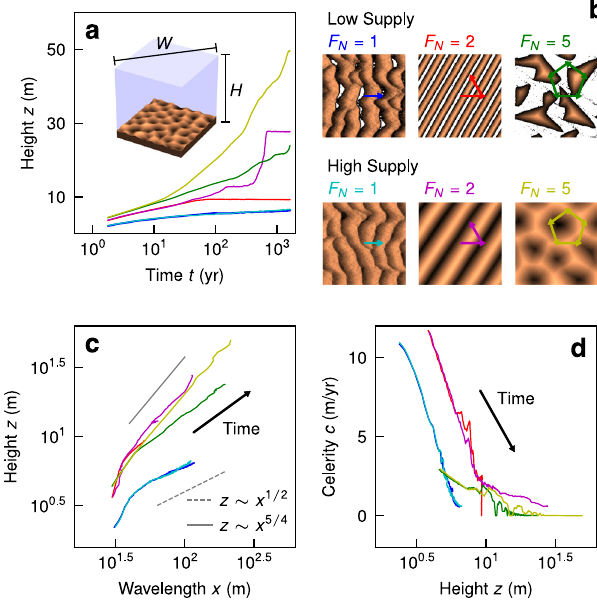
Fig. 4 Numerical experiments of dune growth. a Dune height time-series for ReSCAL experiments. Line colors correspond to experiments shown in b , a snapshot of the yellow experiment at t = 162 yrs shown to de fi ne the horizontally-periodic domain; W = H = 522 m). b Planform snapshots of each experiment at the fi nal timestep t = 1, 624 yrs; color is normalized elevation (dark is lower), white is non-erodible bedrock. The number of fl ux directions F N is given, as are the fl ux vectors for each experiment. The top row of low-supply experiments have η = 3.5 m of fl at sand initially, whereas the bottom row have η = 35 m of fl at sand initially. c Wavelength x against height z for each experiment coarsening over time; bounding powerlaws from the natural data (values in legend) given in Fig. 2a also shown. d Dune height z against celerity (i.e., migration speed) c . Time arrows given in c and d for